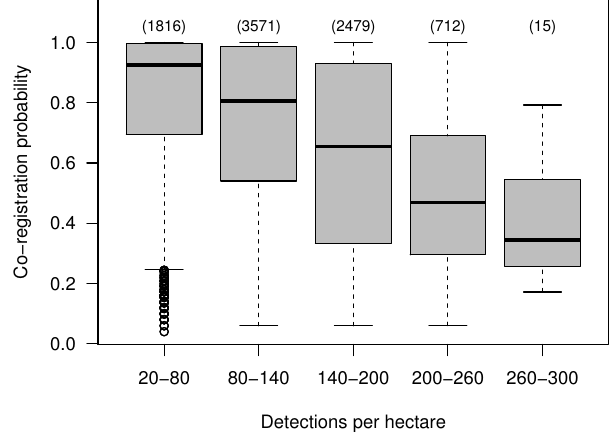
Figure 11. Effect of the number of detections per hectare on the matching probability using the simulated datasets. The numbers in brackets correspond to the number of plots. The whiskers extend to ten times the interquartile range. Outliers are marked by